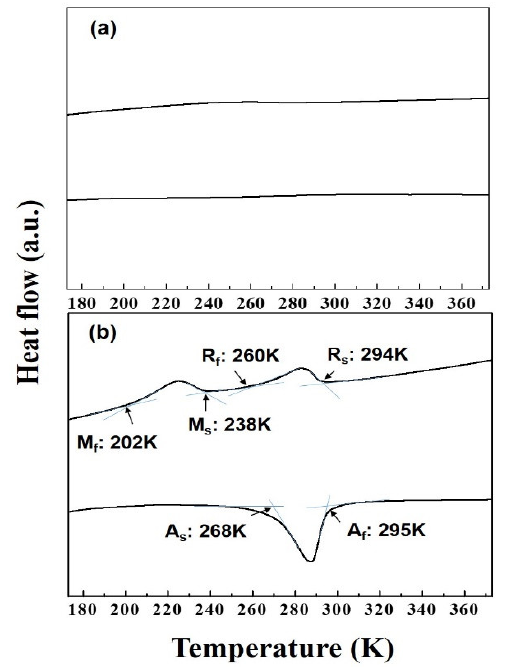
Figure 5. DSC results of Ti-49.9Ni (at %) thin film with a substrate temperature of ( a ) 723 K and ( b ) 773 K. (Deposition condition: growth rate (6.29 nm/min), thickness (1.7 μm)).